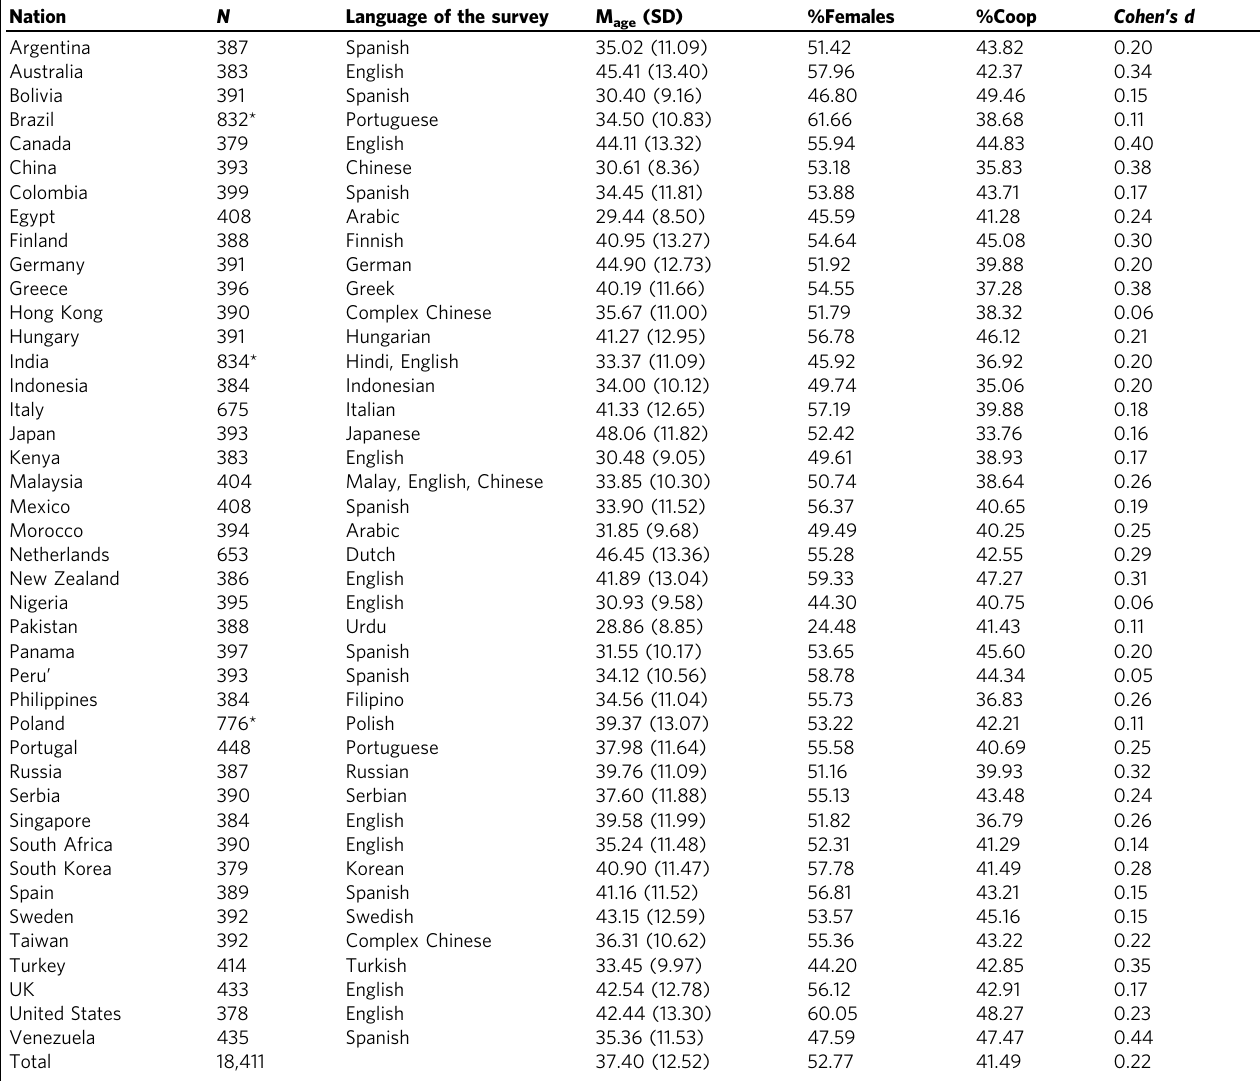
Table 1 Summary of descriptives. Nation N Language of the